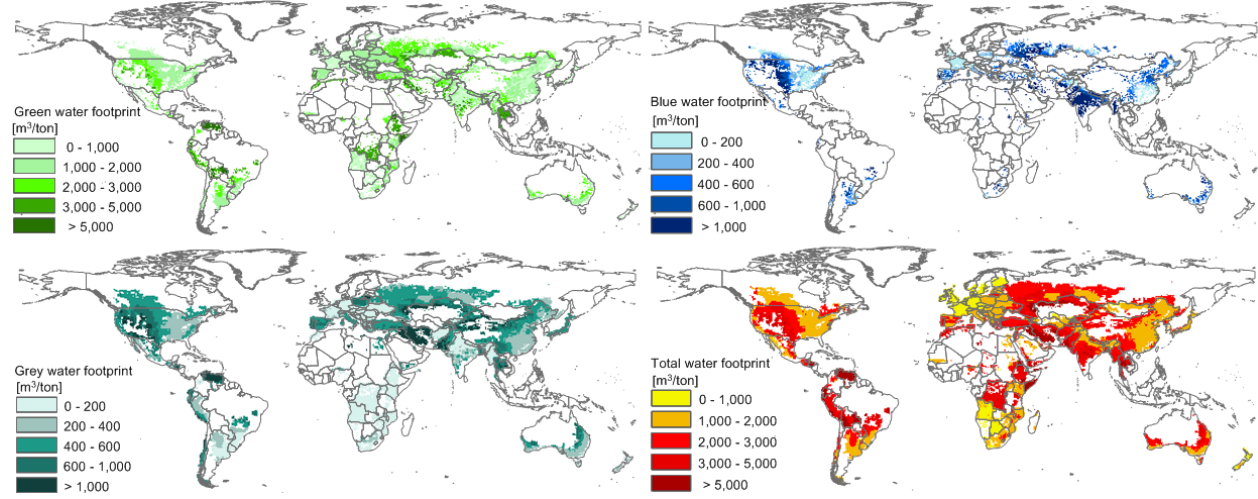
Fig. 1. The green, blue, grey and total water footprint of wheat production per ton of wheat. Period: